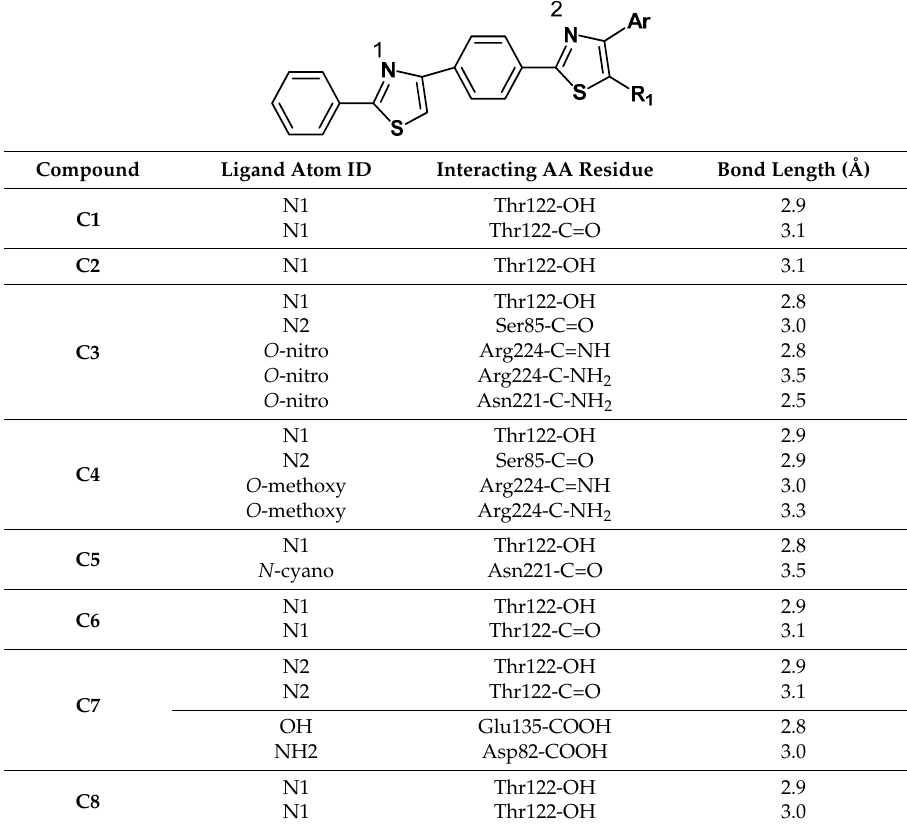
Table 5. Predicted polar contacts between C1 – 8 and Sortase A from E. faecalis (EfSRT_29212).